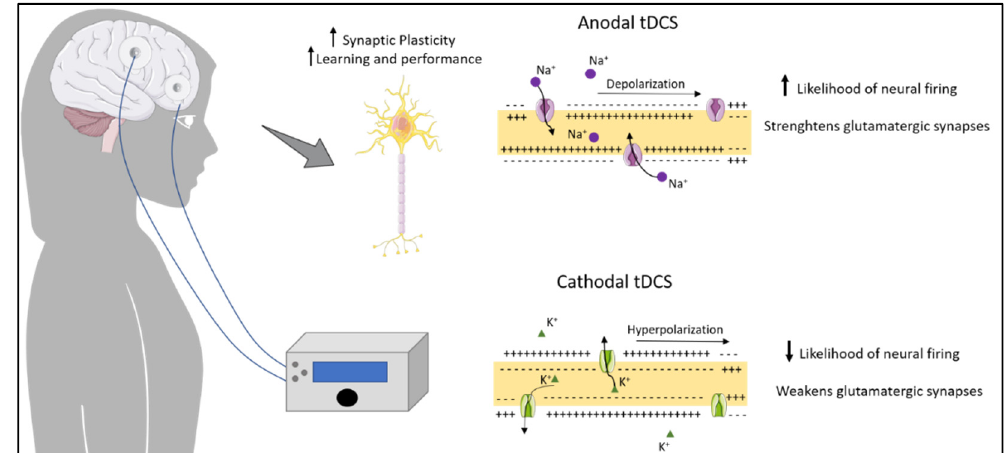
Figure 2. Effects of anodal and cathodal transcranial direct current stimulation (tDCS). The figure represents cortical neurostimulation that could increase synaptic plasticity, leading to improvements in learning and memory. Anodal stimulation increases the likelihood of neuronal firing, strengthening glutamatergic synapses and increasing excitation. Cathodal stimulation decreases likelihood of neuronal firing, weakening glutamatergic synapses and decreasing excitation.